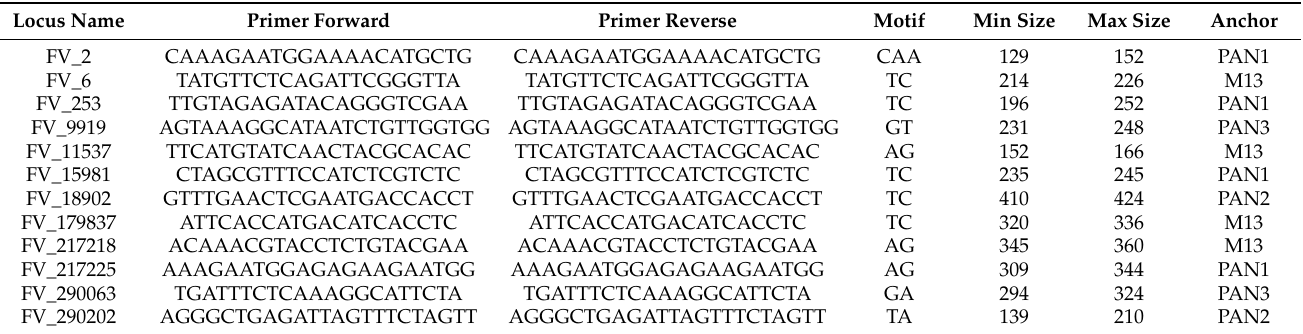
Table 1. List of SSR markers reporting locus name, forward and reverse primer sequences (5 (cid:48) to 3 (cid:48) ), microsatellite motif, minimum and maximum size (bp) and anchor type